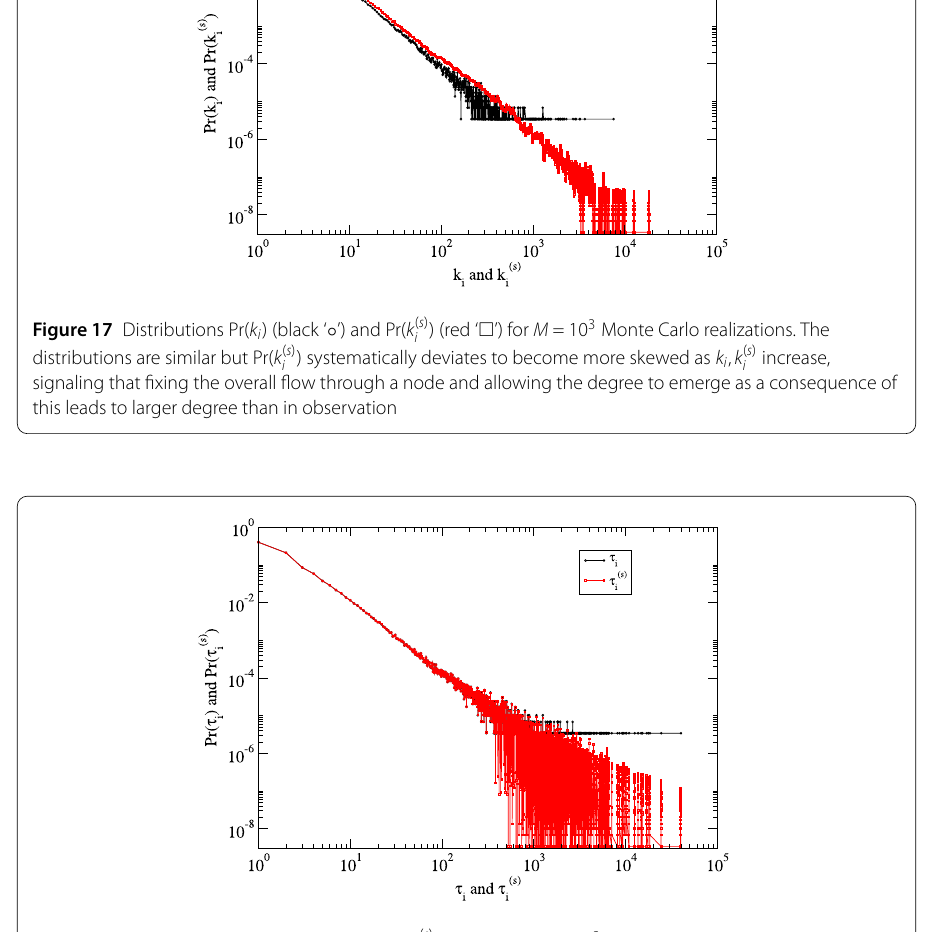
) (red ‘ (cid:3) ’) for M = 10 3 Monte Carlo realizations. i